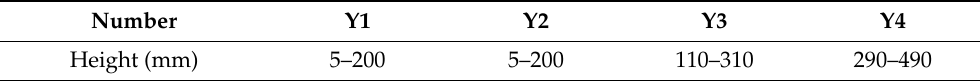
Table 4. Sampling location.